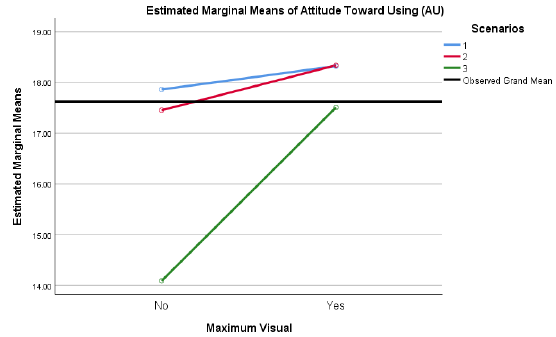
Figure 8. Estimated marginal means—attitude toward using (AU).